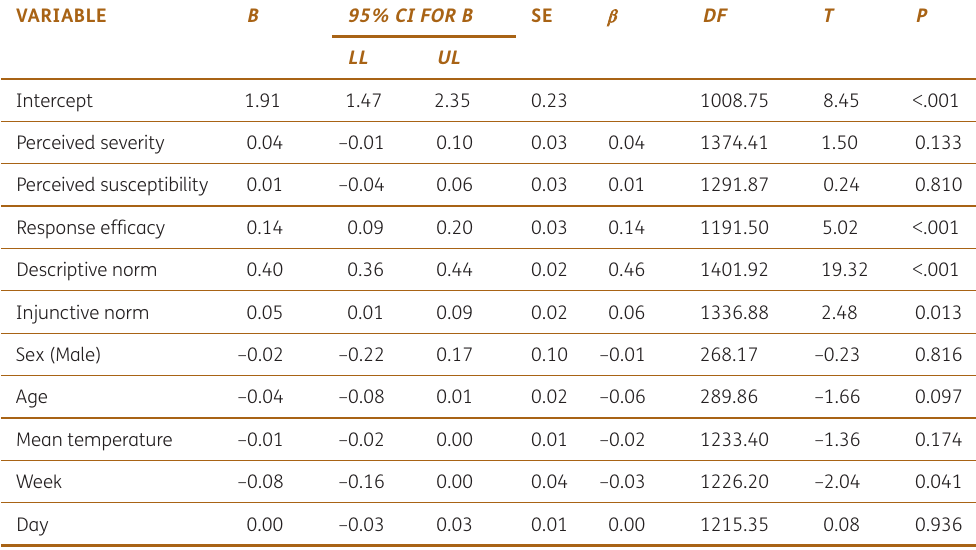
Table 3 Multivariate Linear Mixed-Effects Model Predicting Physical Distancing Behavior in the University Sample. Note : N = 305. ICC = .47. Marginal R 2 = .35. Conditional R 2 = Participant